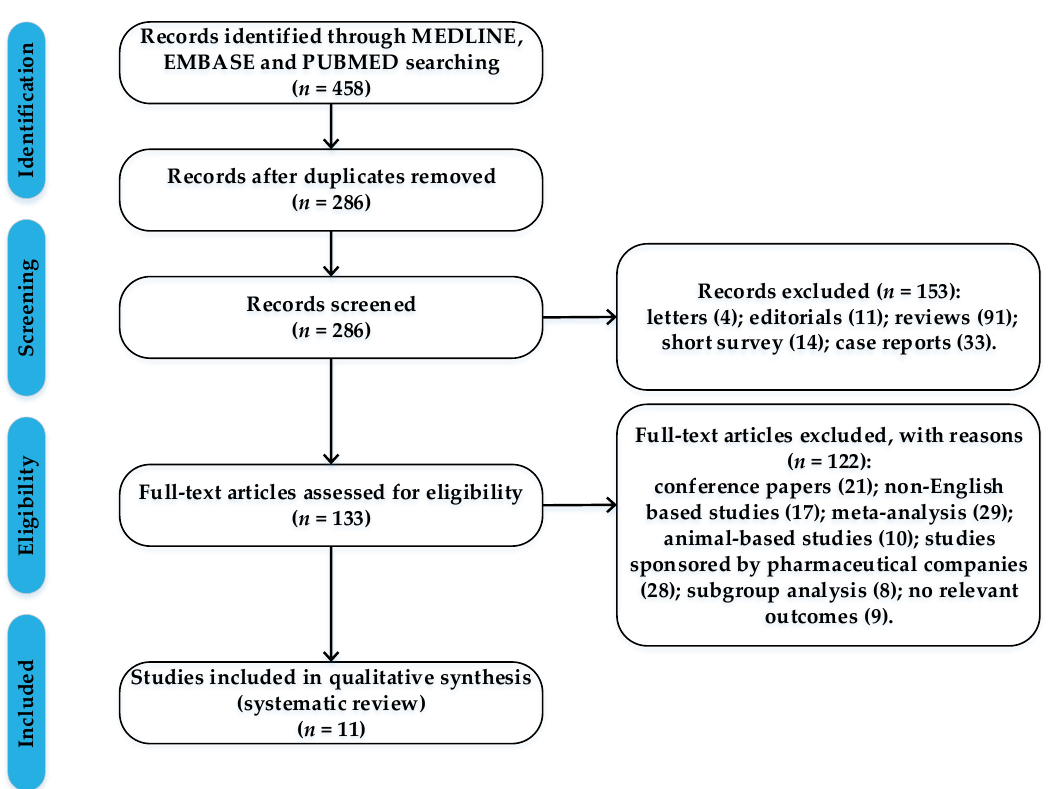
Figure 1. Flow chart with the process of article selection.